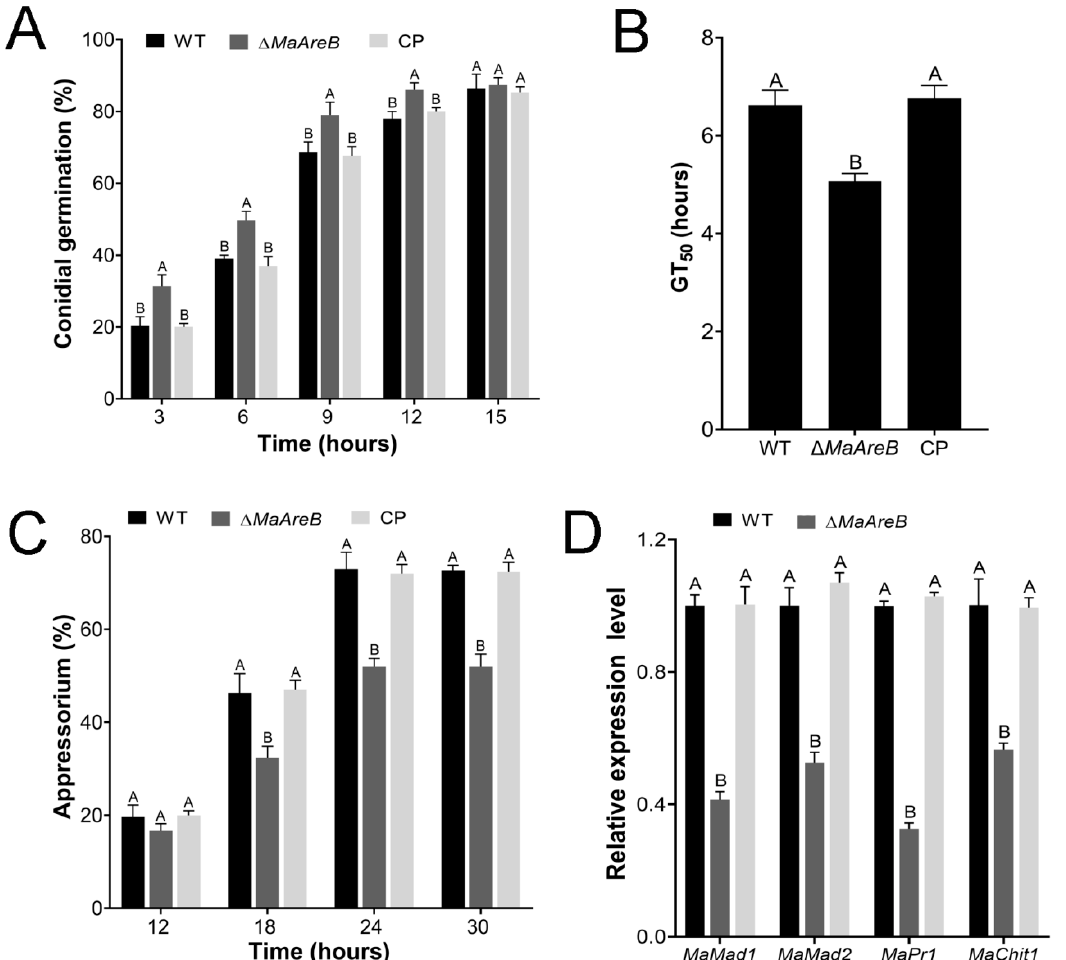
Figure 7. Lack of MaAreB impaired appressorium formation. The conidial germinations ( A ), GT 50 s ( B ) and appressorium formations ( C ) of the WT, Δ MaAreB and CP strains on the locust hind wings cultured at 28 °C for hours. ( D ) qRT-PCR analysis of genes involved in adhesion ( MaMad1 and MaMad2 ) and cuticle penetration ( MaPr1 and MaChit1 ). A & B, p < 0.05 (Tukey’s HSD). The p -values in Figure 7A-D are listed in supplementary Table S3.